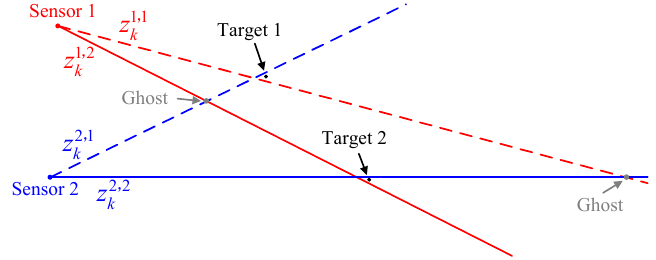
Figure 2. A scenario with 2 passive sensors and 2 targets.